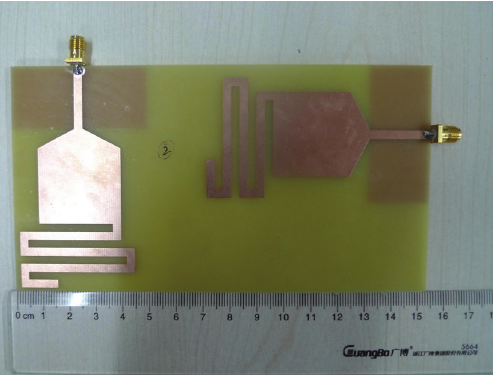
Figure 5: Photograph of the fabricated antenna.